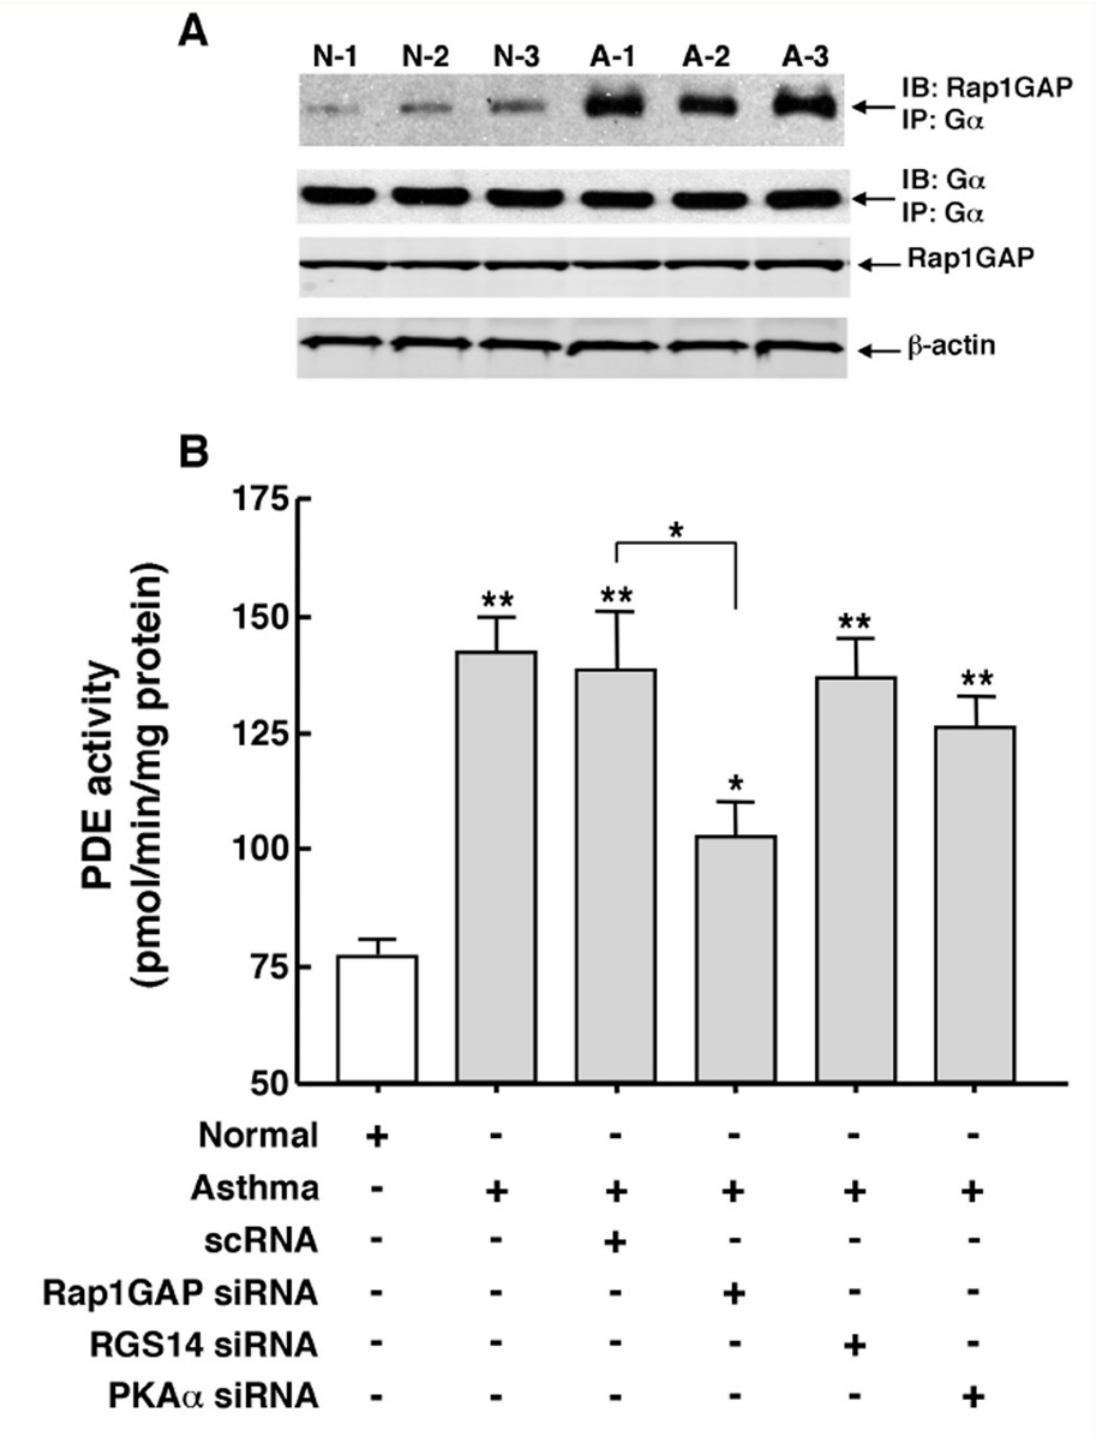
Fig 6. Constitutively increased co-localization of Rap1GAP with G α protein contributes to upregulated PDE activity in asthmatic HASM cells. ( A ) Co-IP analysis demonstrating that, under comparable protein loading given by similar immunoblotted levels of co-immunoprecipitated G α with anti-G α immunoprecipitate, relative to 3 normal HASM cell lines, 3 asthmatic HASM cell lines exhibit markedly increased levels of co-immunoprecipitated Rap1GAP. Note: similar conditions of protein loading are also reflected by comparable immunoblotted levels of Rap1GAP, and β -actin. ( B ) Relative to normal HASM cells, intrinsically heightened PDE activity in asthmatic HASM cells is significantly suppressed by ~40% (p < 0.05) in asthmatic cells transfected with a pool of